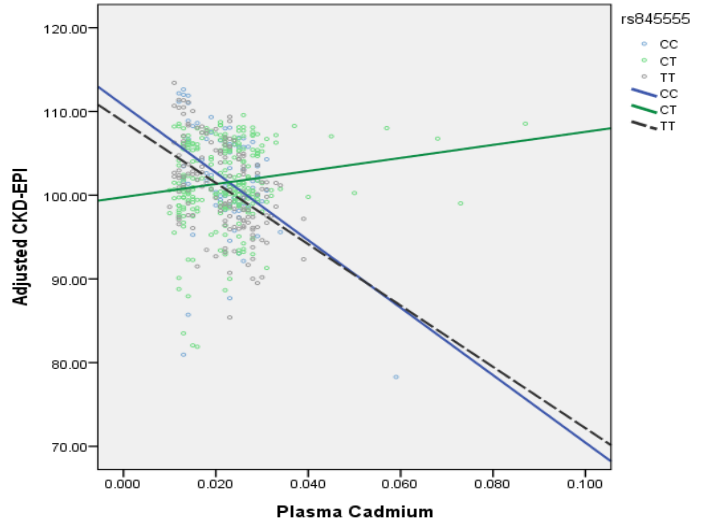
Figure 2. Interaction plot for Cadmium-rs845555 polymorphism and adjusted